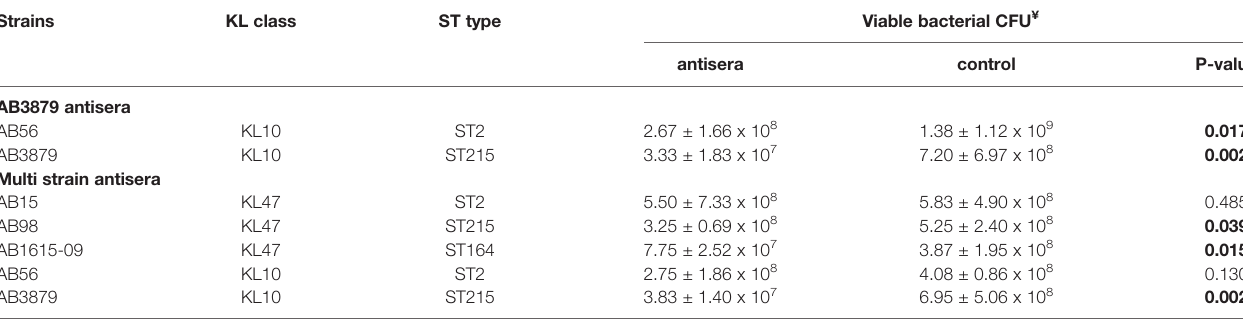
TABLE 2 | Total CFU counts to measure the growth inhibitory effects of AB3879 antisera and multi strain antisera.